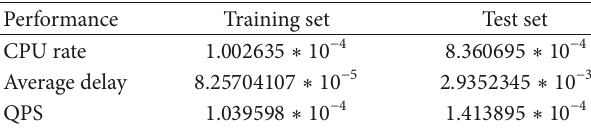
Table 5: Result of model for different performance on data set B.